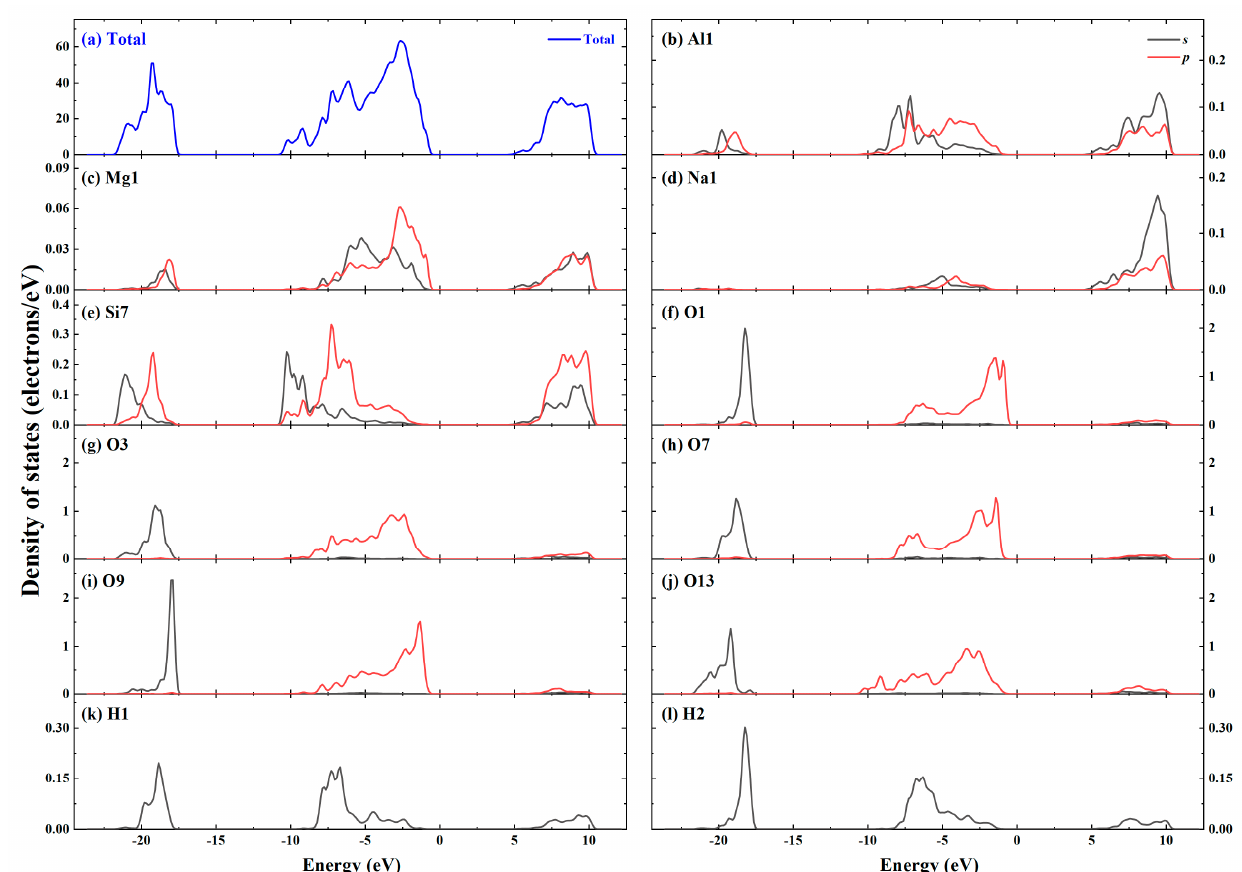
Figure 7. The total ( a ) and partial density ( b – l ) of states of Na-MMT at 19.92 GPa.